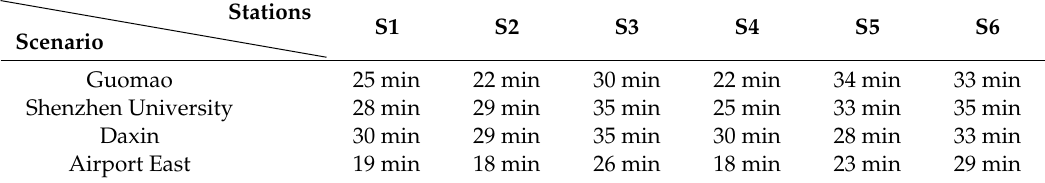
Table 4. Dynamic elapsed time thresholds of four stations under six scenarios.